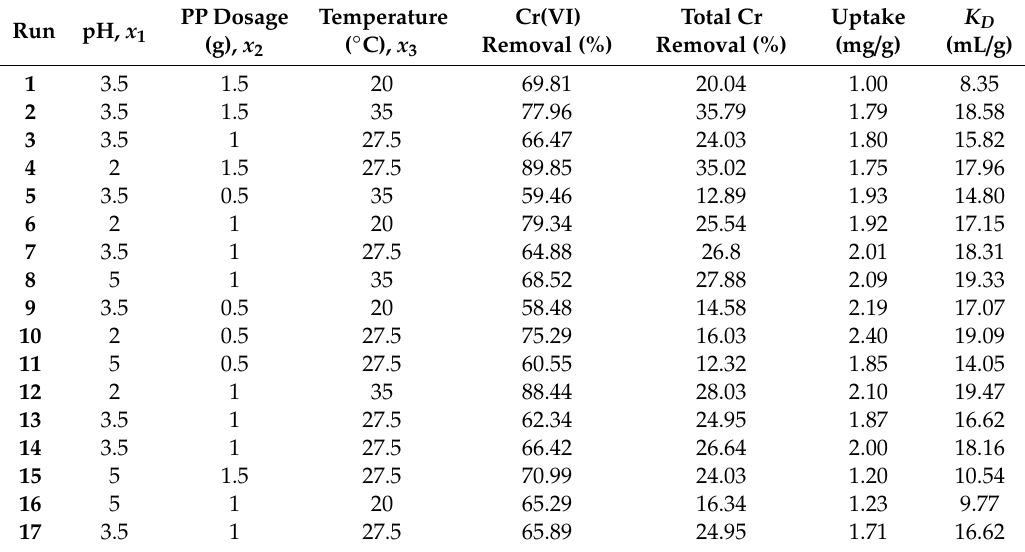
Table 1. Box–Behnken experimental design matrix and responses in terms of real factors and calculated uptake and K D